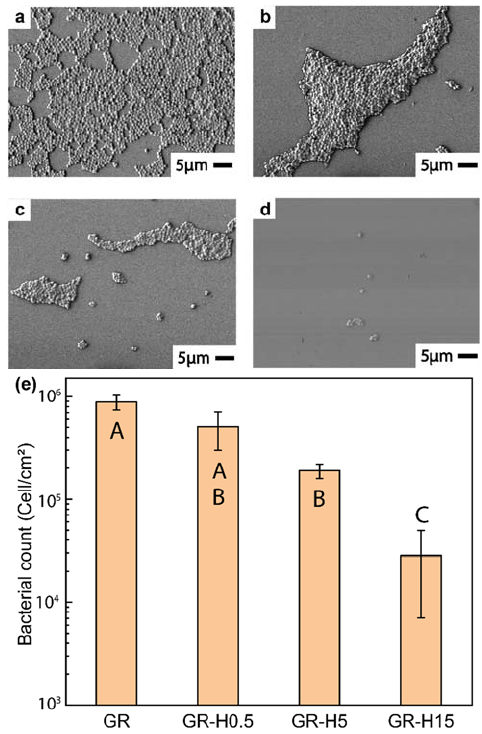
Figure 4. Scanning electron microscopy (SEM) micrographs of ( a ) GR ( b ) GR-H0.5, ( c ) GR-H5, and ( d ) GR-H15 samples after drop-cast inoculation with S. aureus for 4 h and ( e ) the corresponding bacterial counts obtained through the analysis of multiple micrographs. Statistically, the standard errors are reported based on ten random areas collected from three different samples. Letters A, B, C indicates statistically different p -value ( p <